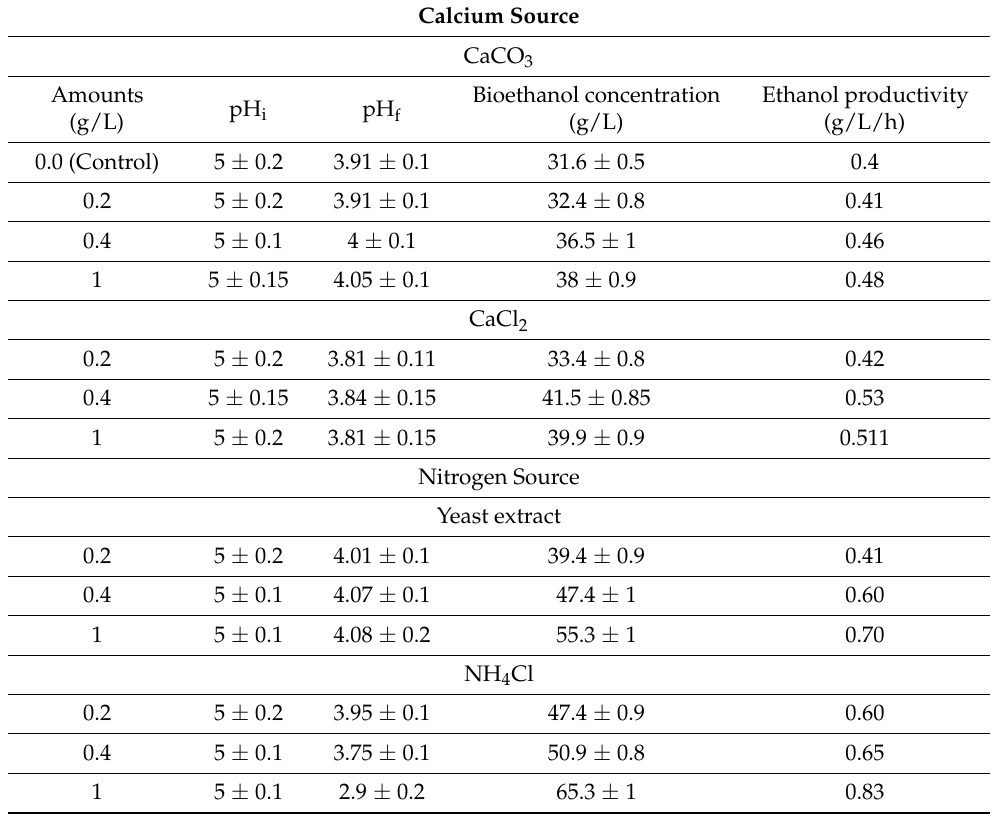
Table 1. Effect of calcium and nitrogen sources on bioethanol fermentation of dates jus medium by S. cerevisiae at 30 ◦ C after 72